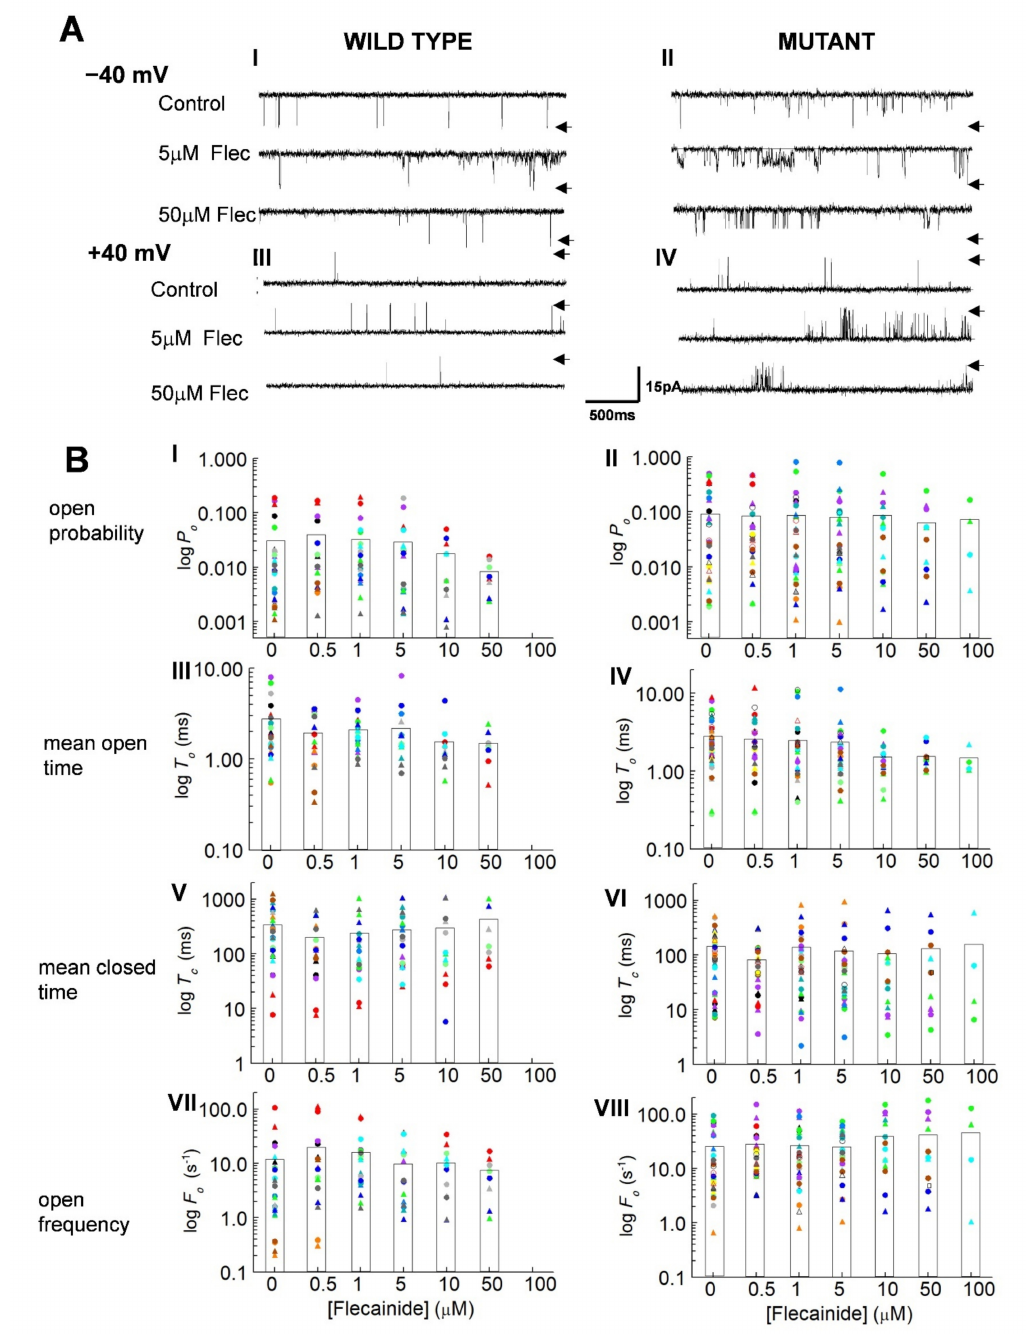
Figure 1. Actions of flecainide on individual wild type (WT) and P2328S RyR2 channels. ( A ) Channel currents before addition of flecainide (upper) and with 5 µ M flecainide (middle) and 50 µ M flecainide (lower) at − 40 mV ( A ) (I,II) and +40 mV ( A ) (III,IV). Arrows indicate maximum open current. ( B ) Individual data for WT ( n = 13) and P2328S ( n = 17) channels. Relative open probability ( P o ) ( B ) (I,II), mean open time ( T o ) ( B ) (III,IV), mean closed time ( T c ) ( B ) (V,VI) and open frequency ( F o ) ( B ) (VII,VIII) at +40 mV (circles) and − 40 mV (triangles). Data for each channel is represented by symbols of the same colour. The bar graphs show the mean values for each of the parameters at each flecainide